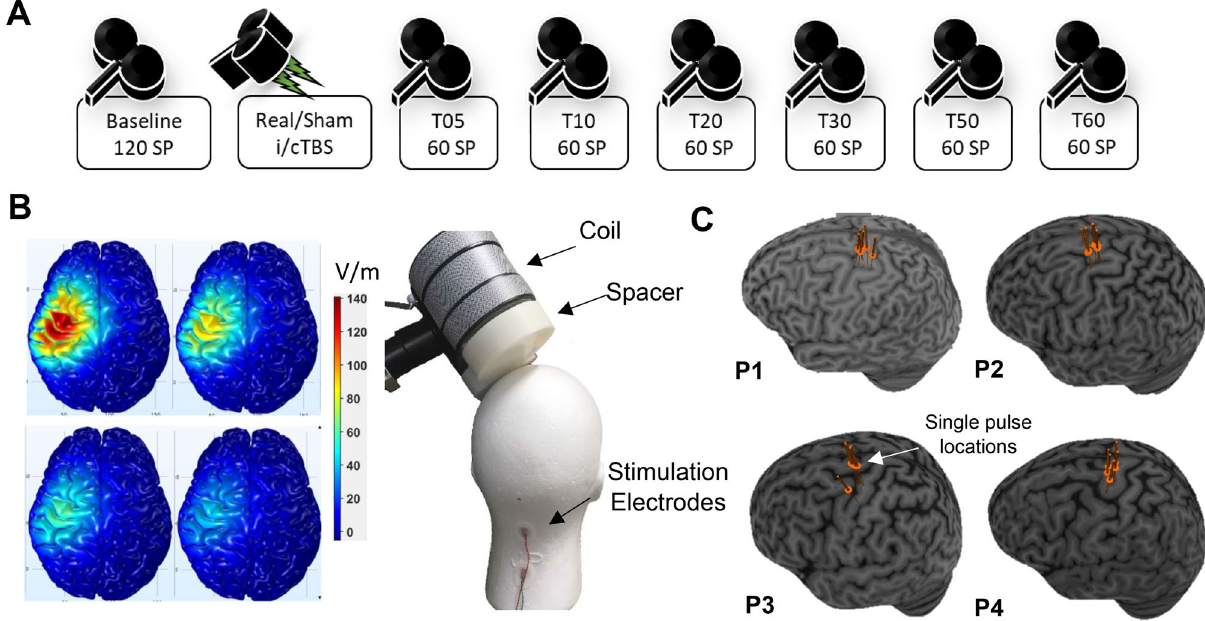
Figure 1. Experimental design. ( A ) Sequence of plasticity protocol in each visit ( SP single pulses). ( B ) Left Panel: Magnitude of the max value of E-Field (V/m) induced in the brain by a TMS coil positioned (from left to right): 0.3 cm, 1.3 cm, 2.3 cm and 3.3 cm above the scalp. Right Panel: TMS coil with attached spacer on dummy head (coil ~ 3.3 cm from dummy head). ( C ) The positions of the motor hotspots over all 6 visits for each of